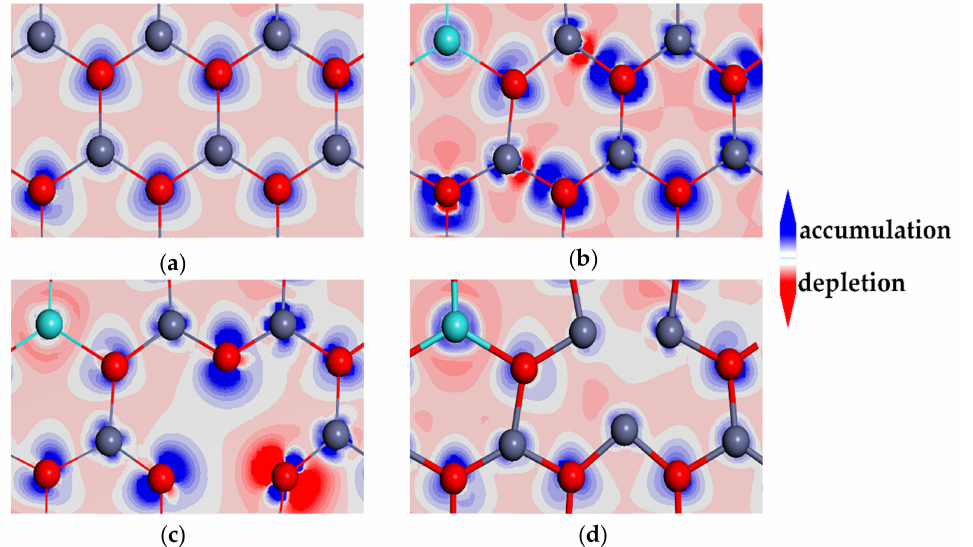
Figure 8. The charge density di ff erences of ( a ) ZnO ML, ( b ) Y-ZnO, ( c ) Y-V Zn -ZnO, and ( d ) Y-V O -ZnO. Electron accumulation and electron depletion are shown in blue and red, respectively, and the areas with minimal change in the electron density are shown in